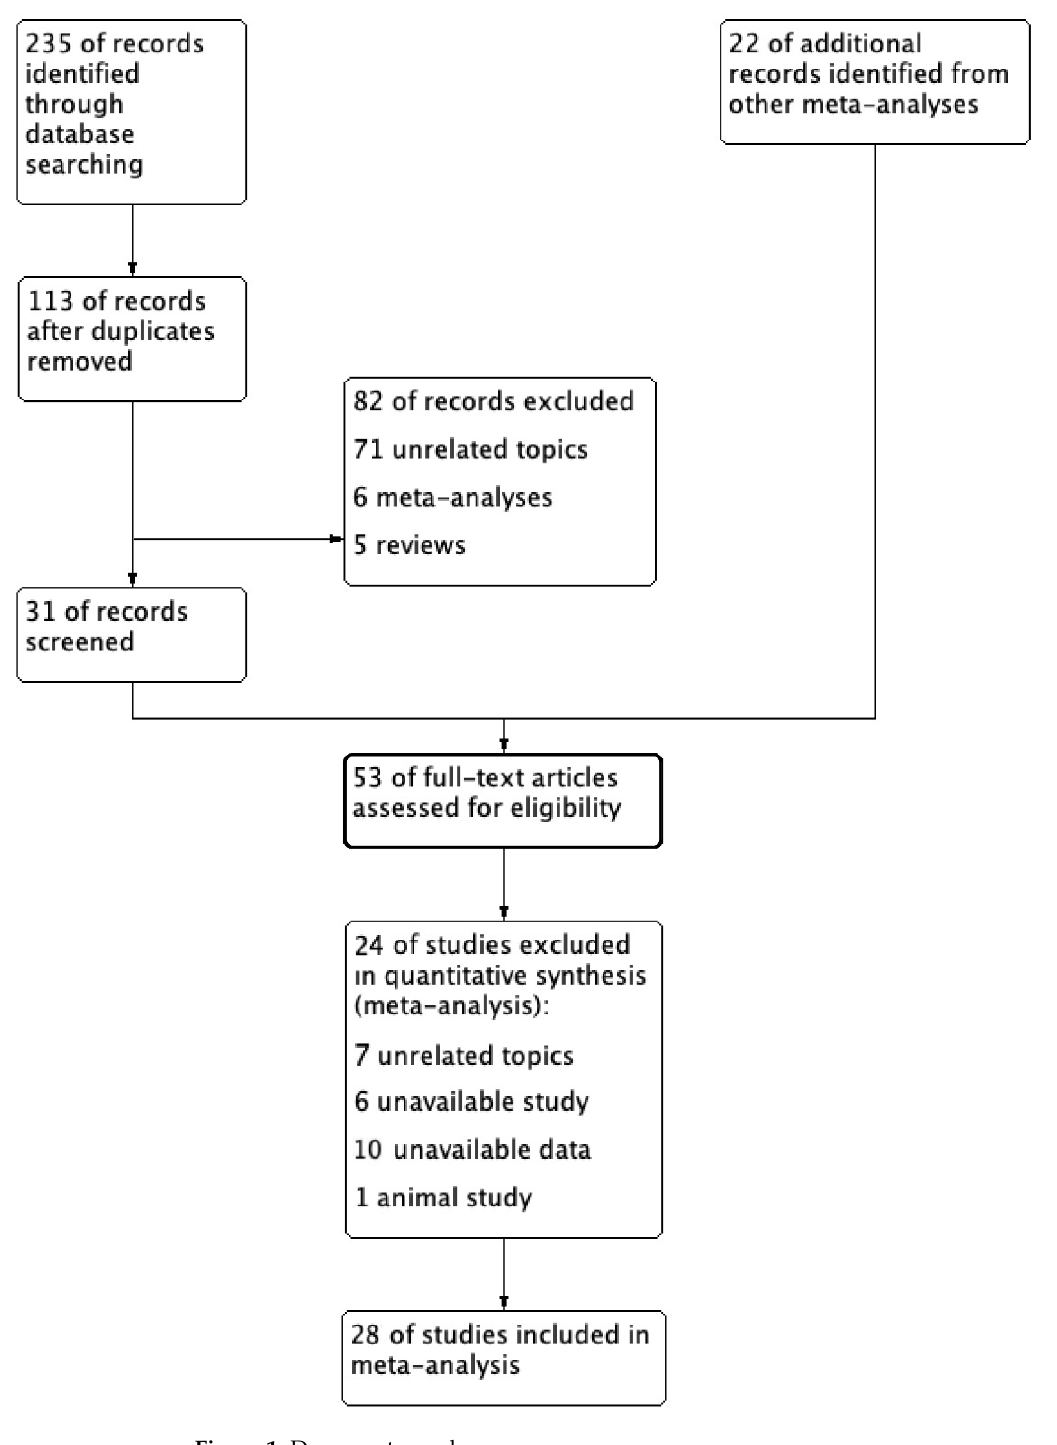
Figure 1. Document search process. Table 1. The characteristics of the included studies.